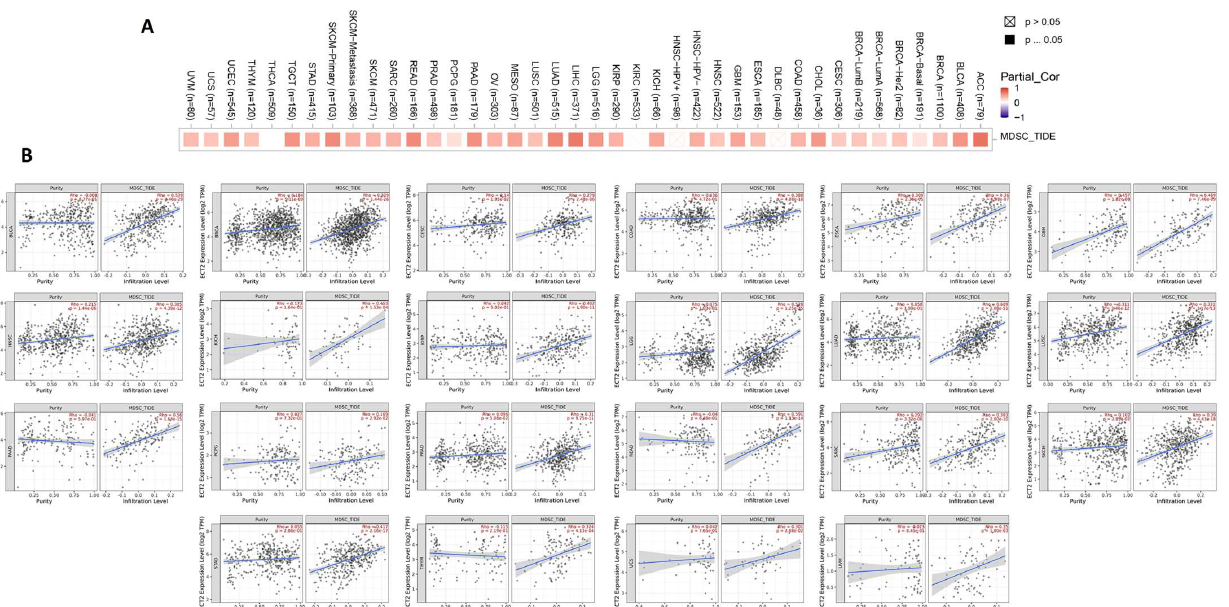
Figure 7. Differential phosphorylation analysis of ECT2 in tumor samples versus normal ones. ( A ) HNSC; ( B ) hepatocellular carcinoma; ( C ) breast cancer; ( D ) lung adenocarcinoma; ( E ) pancreatic adenocarcinoma.